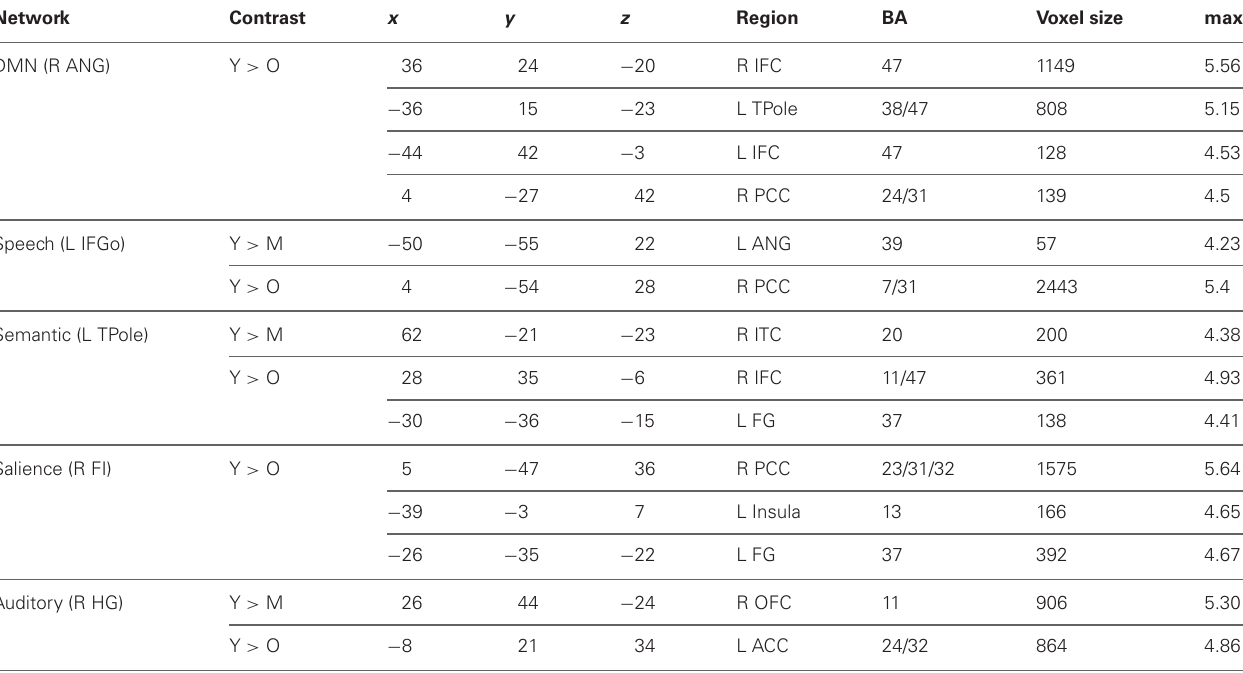
Table A1 | Contrast analysis of structural covariance network trajectories derived from contralateral seeds.